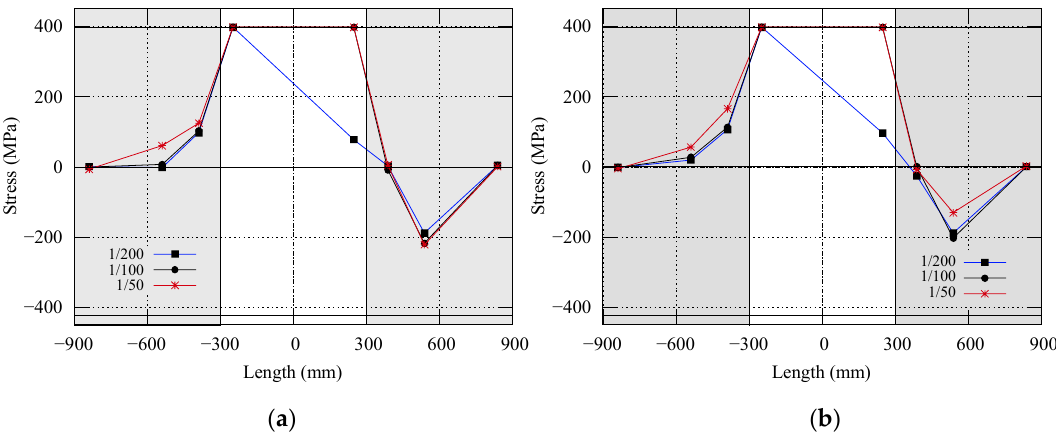
Figure 11. Stress distributions of longitudinal reinforcements: ( a ) BSH; ( b ) BS.